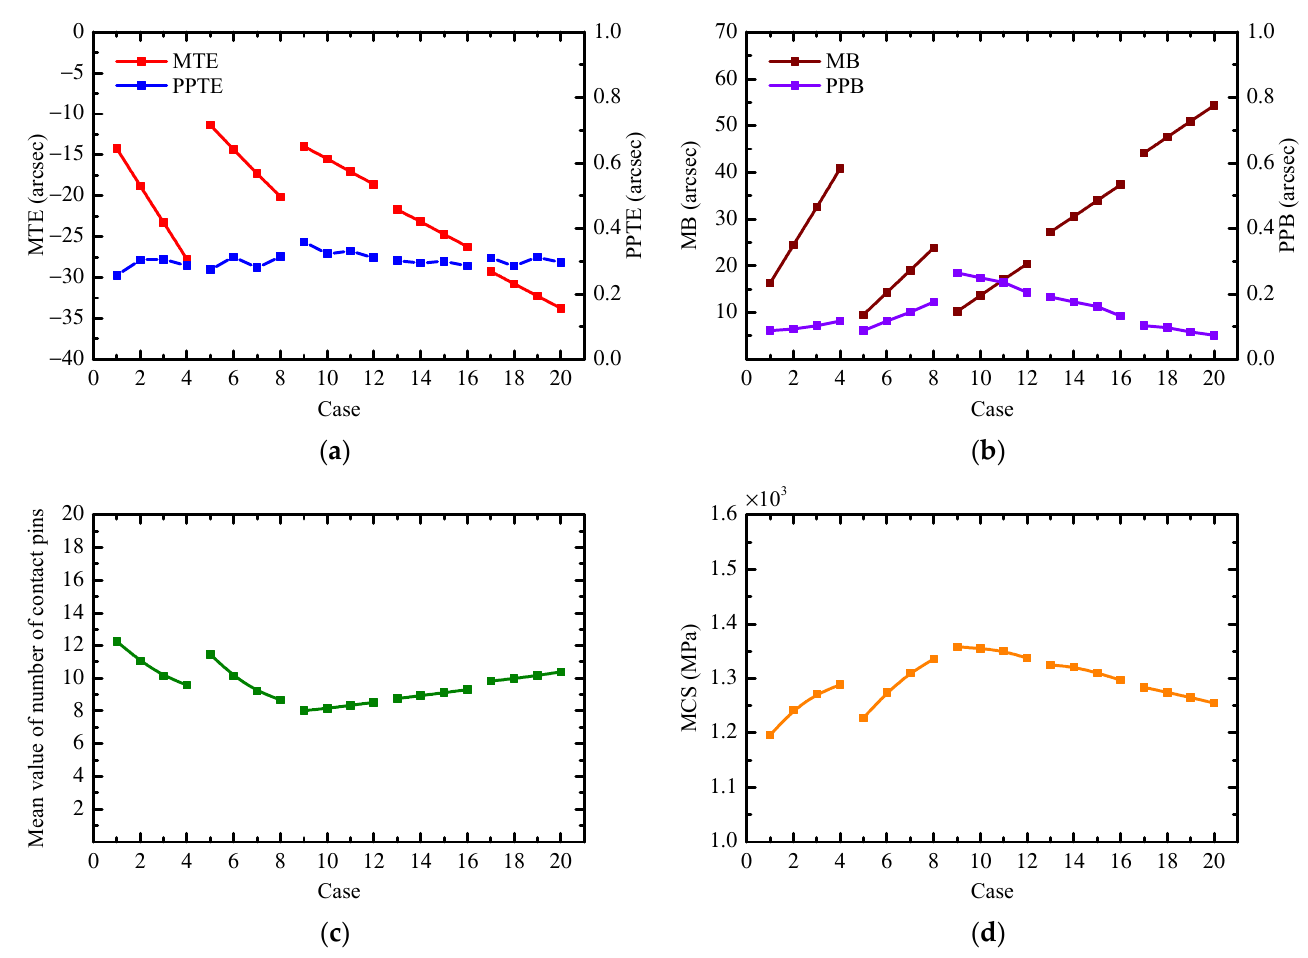
Figure 8. Results with PMs: ( a ) MTE and PPTE, ( b ) MB and PPB, ( c ) mean value of number of contact pins, and ( d ) MCS.